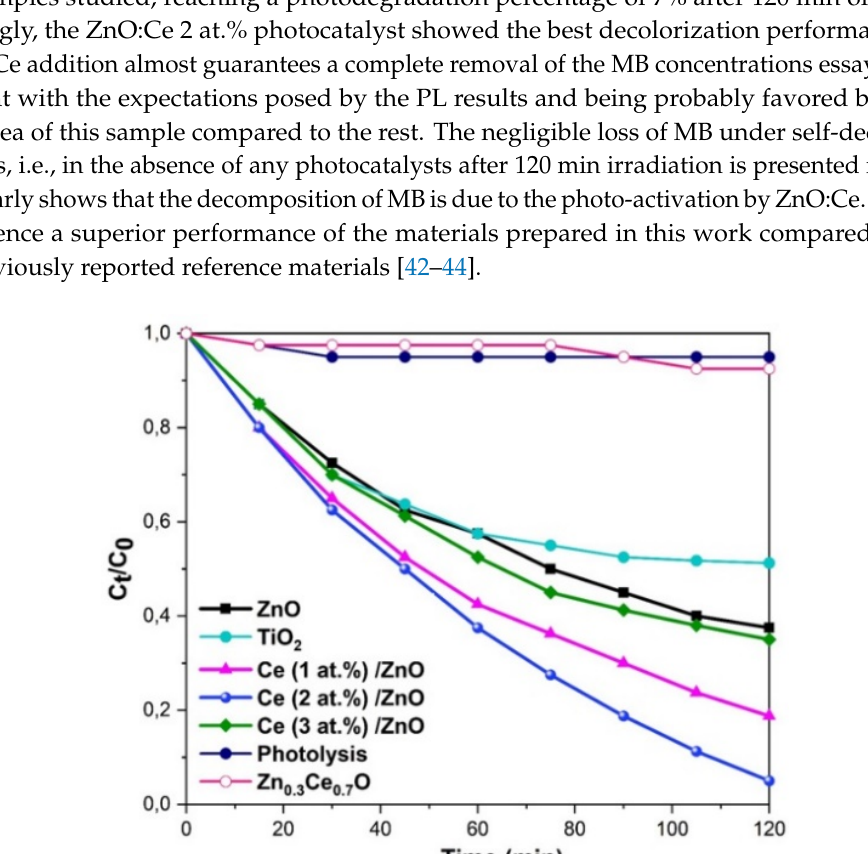
Table 4. Numerical values of the effective rate constant estimated using the LH model.